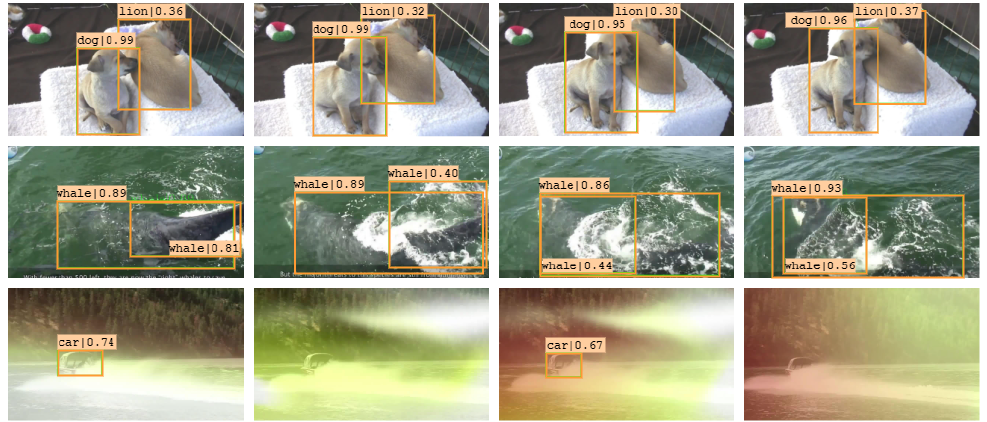
Figure 9. Fail cases of the proposed model: misclassified objects (top), duplicate bounding boxes (middle) and inaccurate or missing predictions